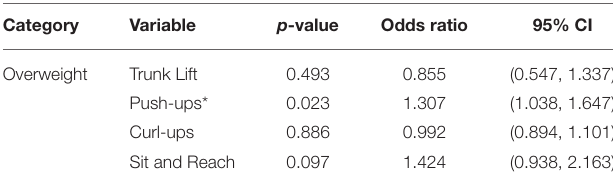
* Indicates statistical significance at the level of p < 0.05.